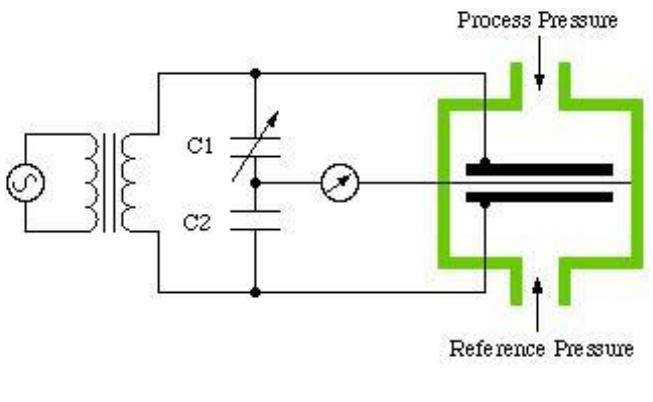
Figure 10. Capacitive pressure sensor construction [36].